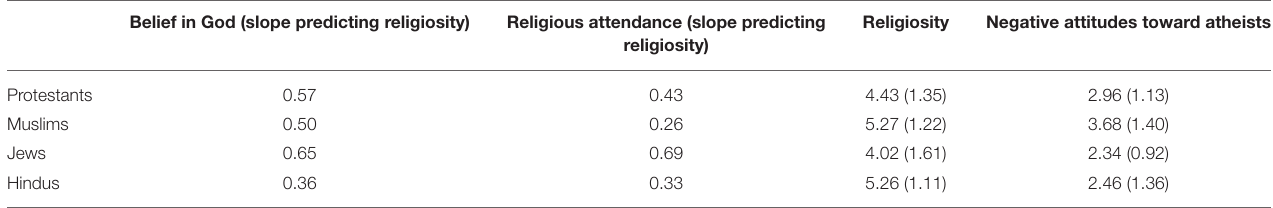
TABLE 4 | Beliefs and practices predicting religiosity, and negative attitudes toward atheists (Study